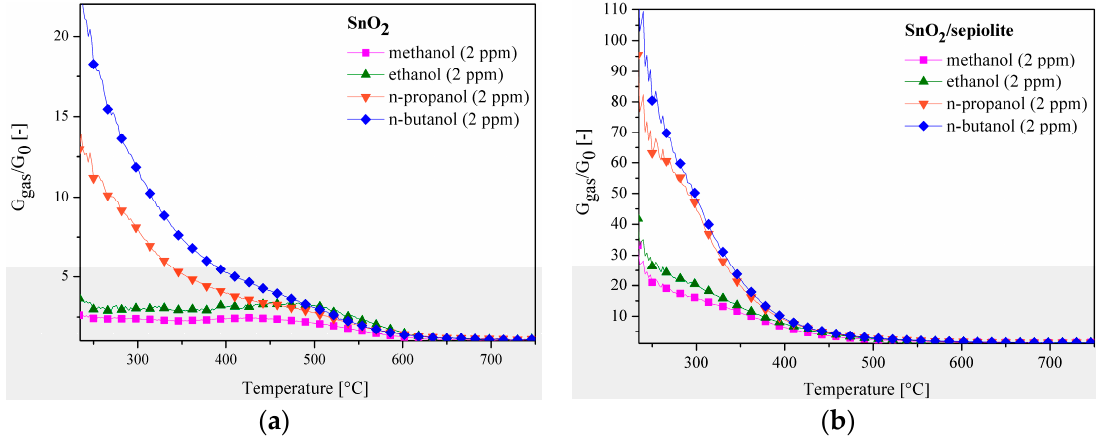
Figure 11. Temperature changes of the SnO 2 sensor sensitivity: ( a ) without a filter; ( b ) with a filter in the atmosphere with a different composition (air with 30% RH + alcohol).